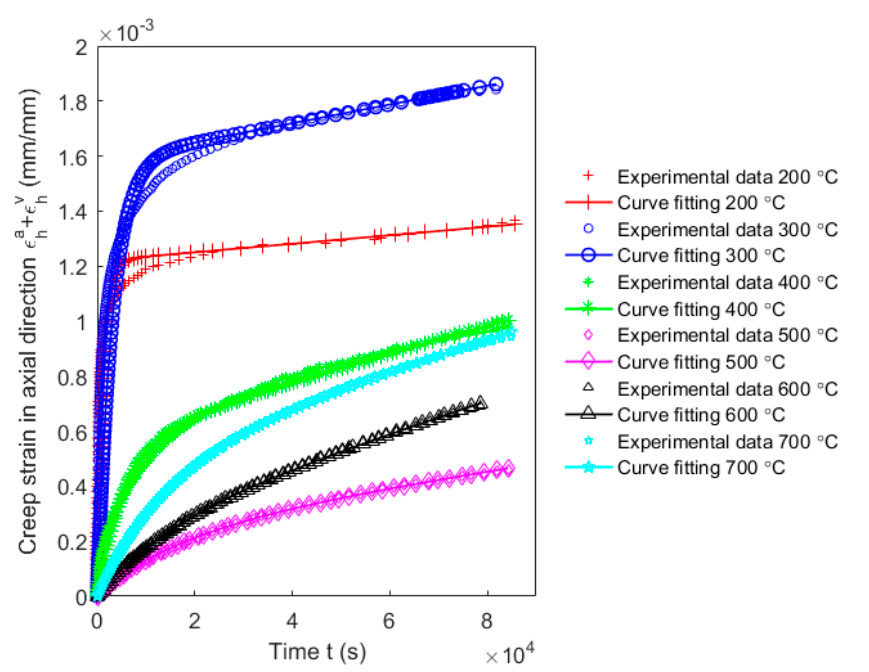
Figure 19. Model prediction of the creep behaviour of carbon anode in the axial direction for different baking temperatures.